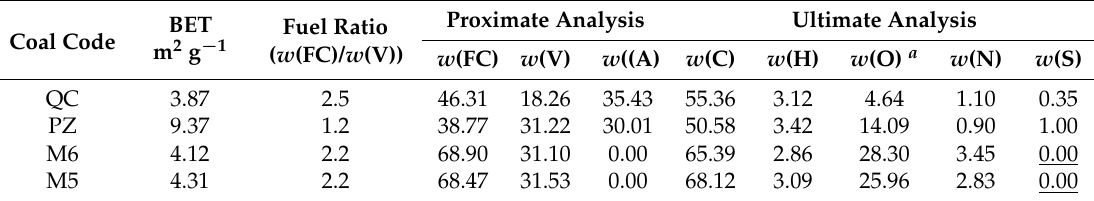
Table 1. The proximate and ultimate analyses of real and synthetic coals (wt%, d).